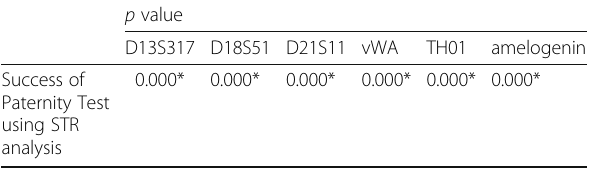
Table 1 Comparison of percentage fetal DNA in loci analysis using Willcoxon Signed Rank test